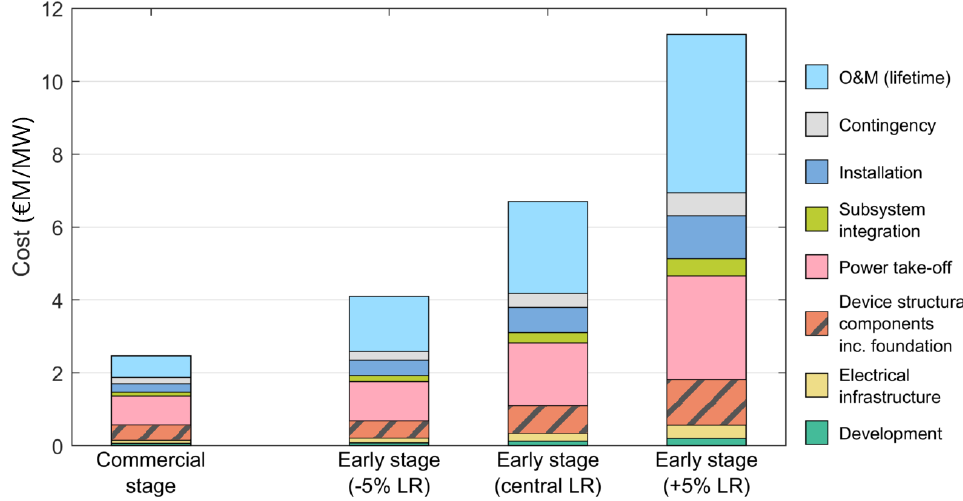
Figure 6. Results per cost centre for tidal stream commercial-stage and early-stage CAPEX. Note that some subsystems are combined, shown by hatched bars.